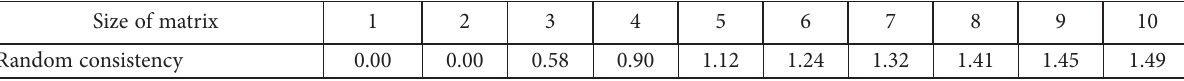
Table 2. Random consistency values according to the size of matrix (source: Saaty, 1990) Size of matrix Random